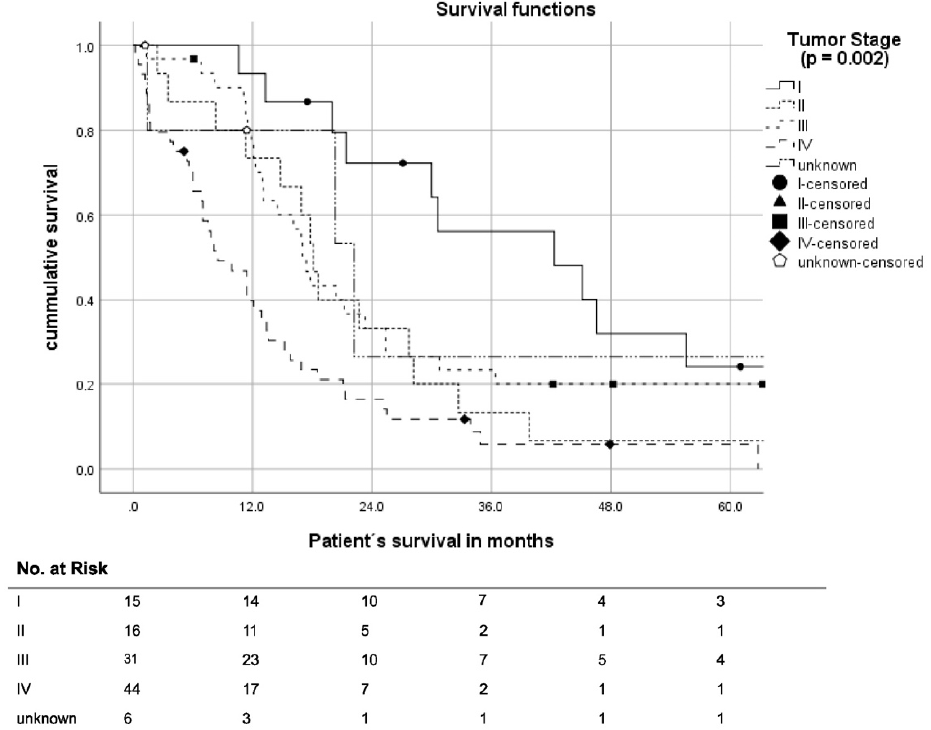
Figure 4. Kaplan–Meier curves of patient survival according to tumor stage.